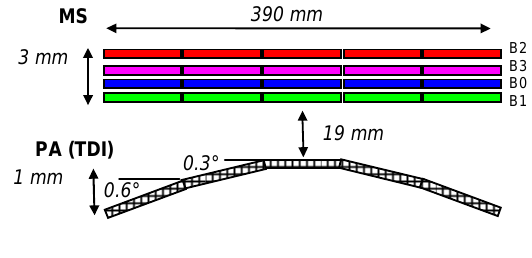
Figure 6: PHR Focal plane layout